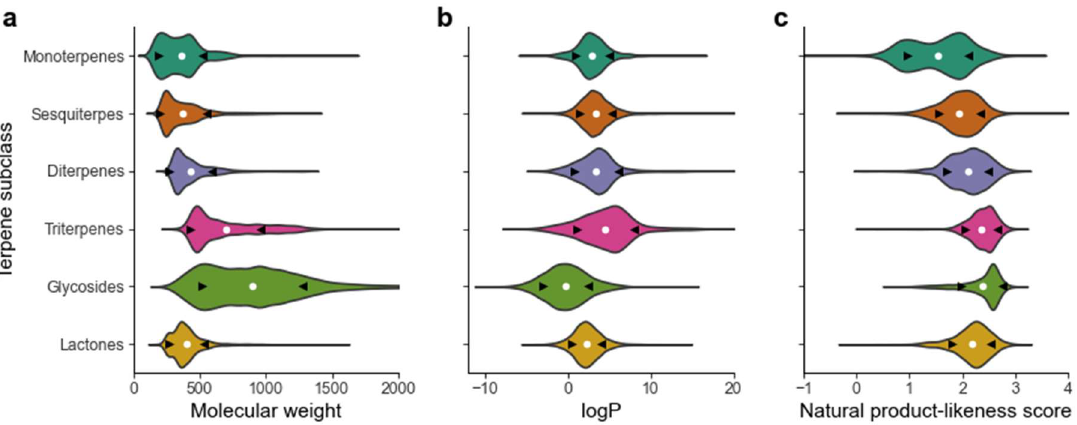
Figure 5 - Distribution of ( a ) molecular weight, ( b ) logP and ( c ) natural product-likeness score across different terpenes subclasses. White mark (•) represents the mean. Left black arrow represents the mean - std and the right arrow the mean + std.